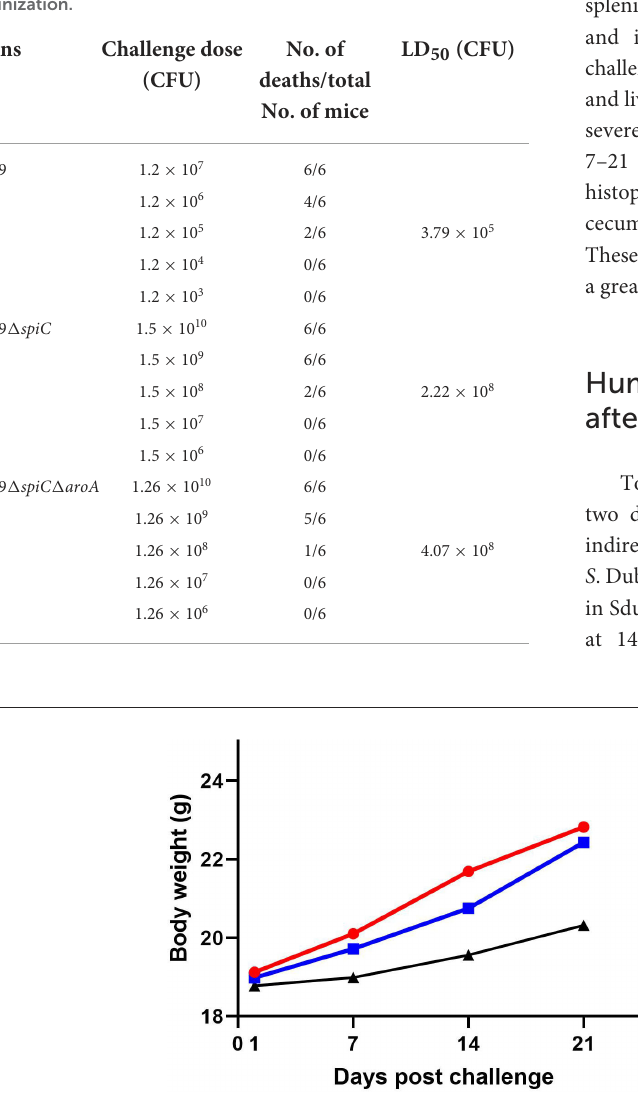
FIGURE2 The body weight of mice after immunization. Groups of 6-week-old BALB/c mice were intramuscularly immunized with Sdu189 1 spiC and Sdu189 1 spiC 1 aroA , and the control group received 100 µ l PBS. The body weights of the experimental mice were determined at 1, 7, 14, and 21 days post-immunization. Data are presented as mean ±